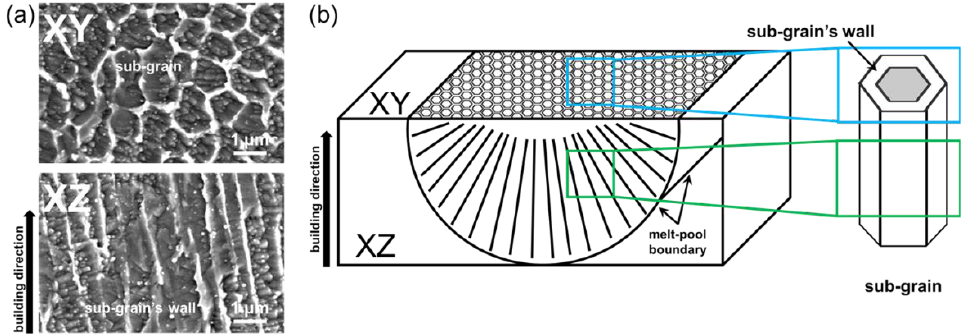
Figure 7. ( a ) Microstructures of the XZ and XY and ( b ) schematic illustrations of the sub-grain structure in a single melt track.